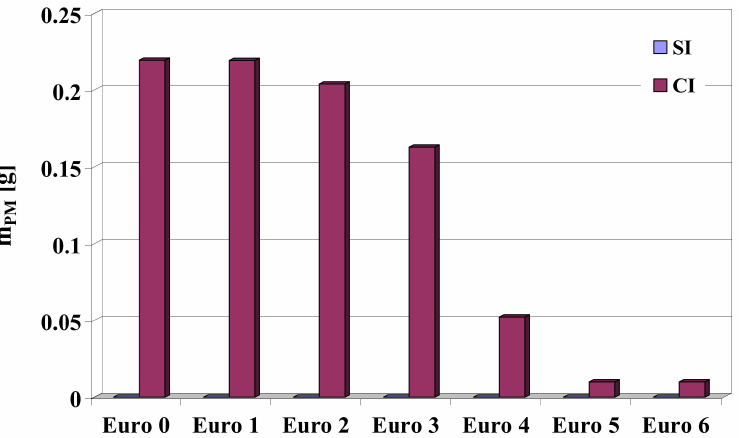
Figure 10. Additional emission of particulate matter—m PM , during warm-up of the spark-ignition engine—SI or the compression-ignition engine—CI of passenger cars of Euro 0–Euro 6 pollutant emission categories, under the model conditions for vehicle traffic.